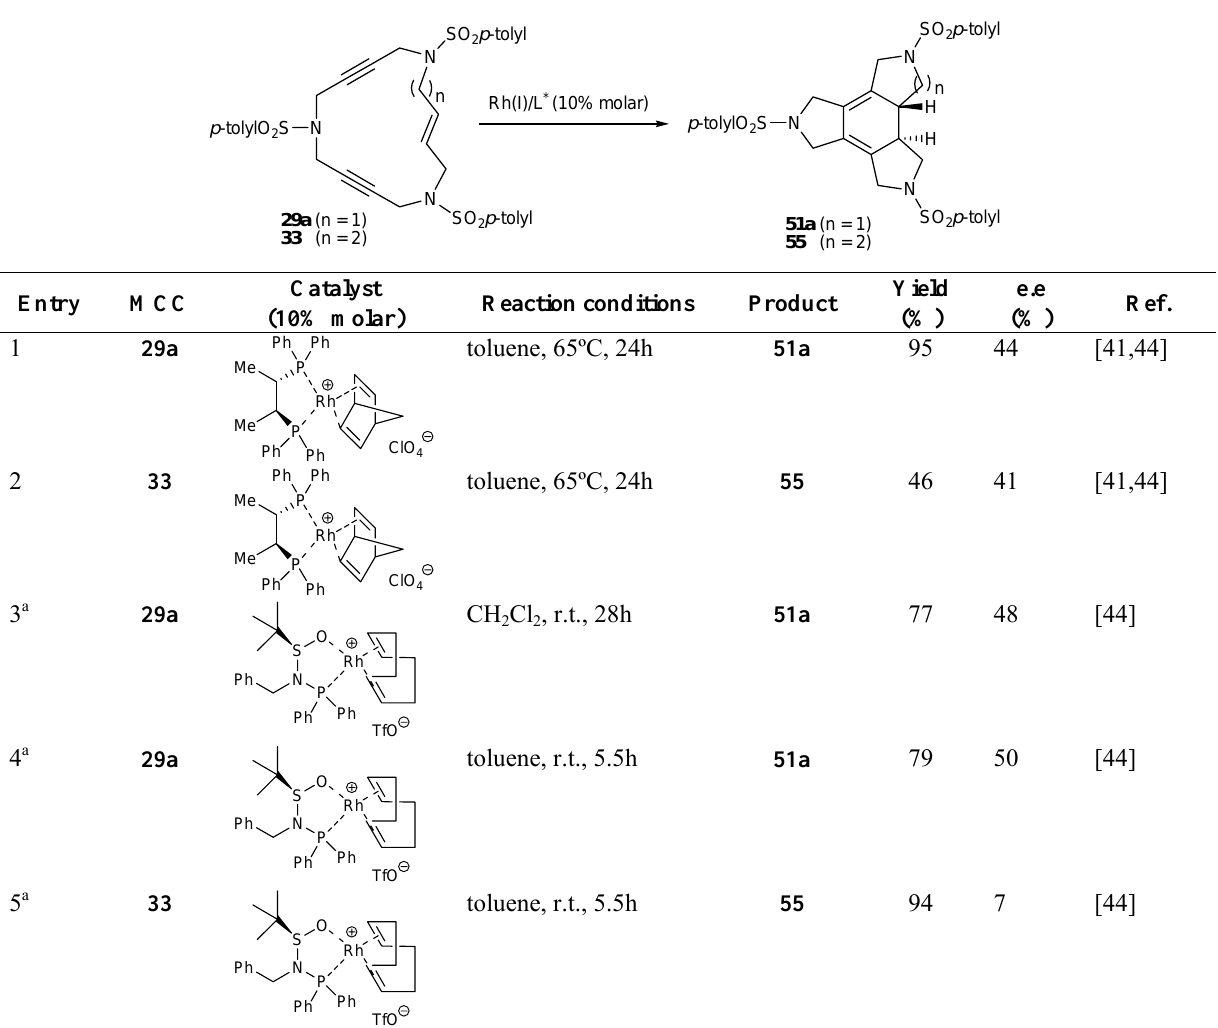
Table 4. Enantioselective [2+2+2] cycloaddition reactions of 29a and 33 . SO 2 p